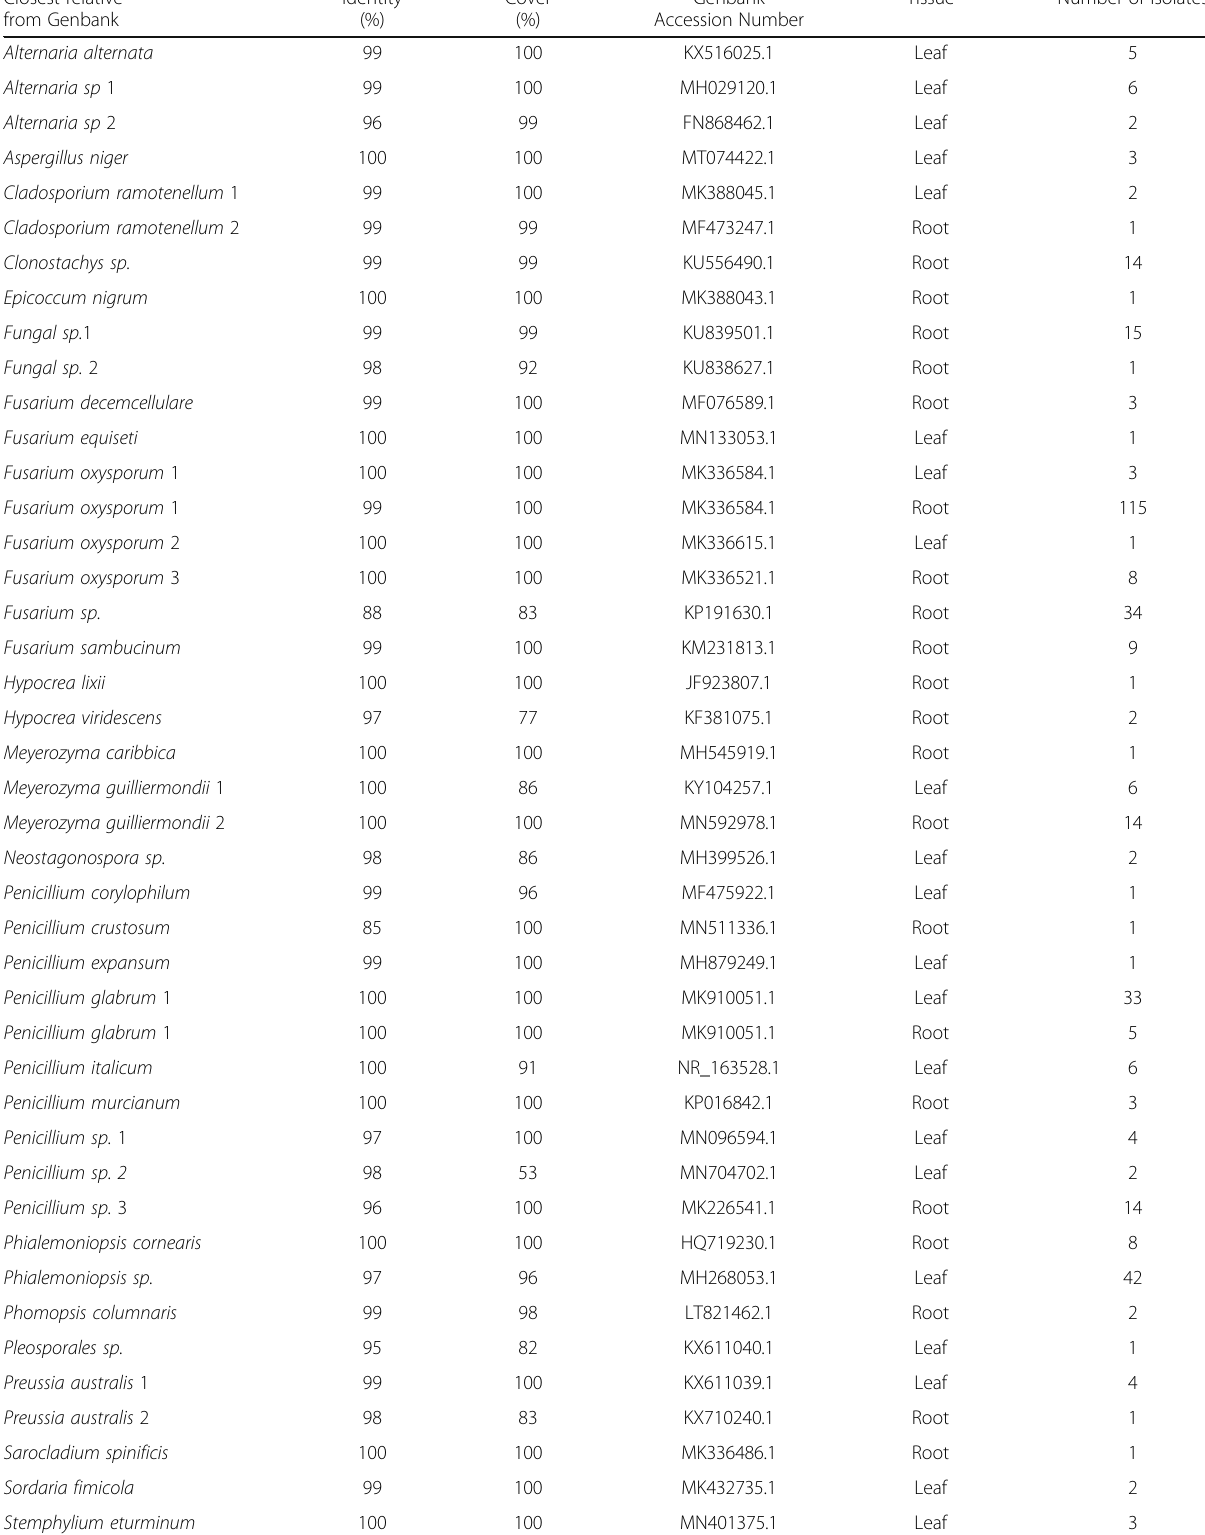
Table 1 Identified fungal endophyte species for leaf and root tissues of Aristolochia chilensis . The total number of isolates (considering the total individuals) for each OTU is indicated Closest relative Identity from Genbank